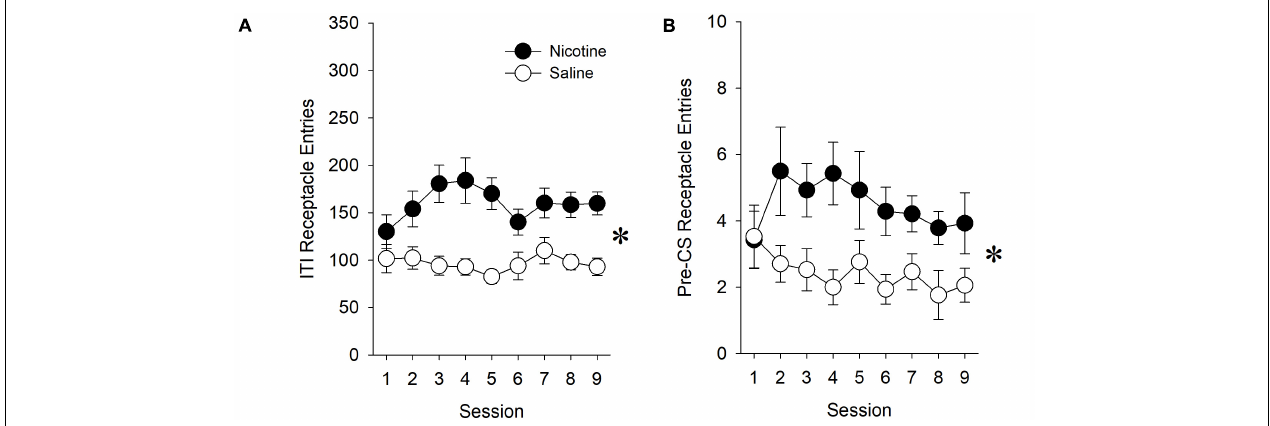
FIGURE 3 | In experiment 1, nicotine increased goal location entries during both the entire ITI and the 10-s pre-CS period immediately prior to lever presentations. In order to determine whether nicotine had a non-specific effect on behavior directed toward the goal location, we assessed the effect of nicotine on receptacle entries during both the entire ITI (A) and during the 10-s pre-CS period (B) . Because nicotine increased receptacle entries during both the ITI and the pre-CS period in experiment 1, we express the number of receptacle entries in our evaluation of goal-tracking ( Figure 4A ) as an elevation score, as opposed to raw values. The elevation score was calculated by subtracting the number of receptacle entries made during the 10-s pre-CS from the number of receptacle entries made during the 10-s lever presentation. Asterisk ( ∗ ) indicates significant Treatment × Session